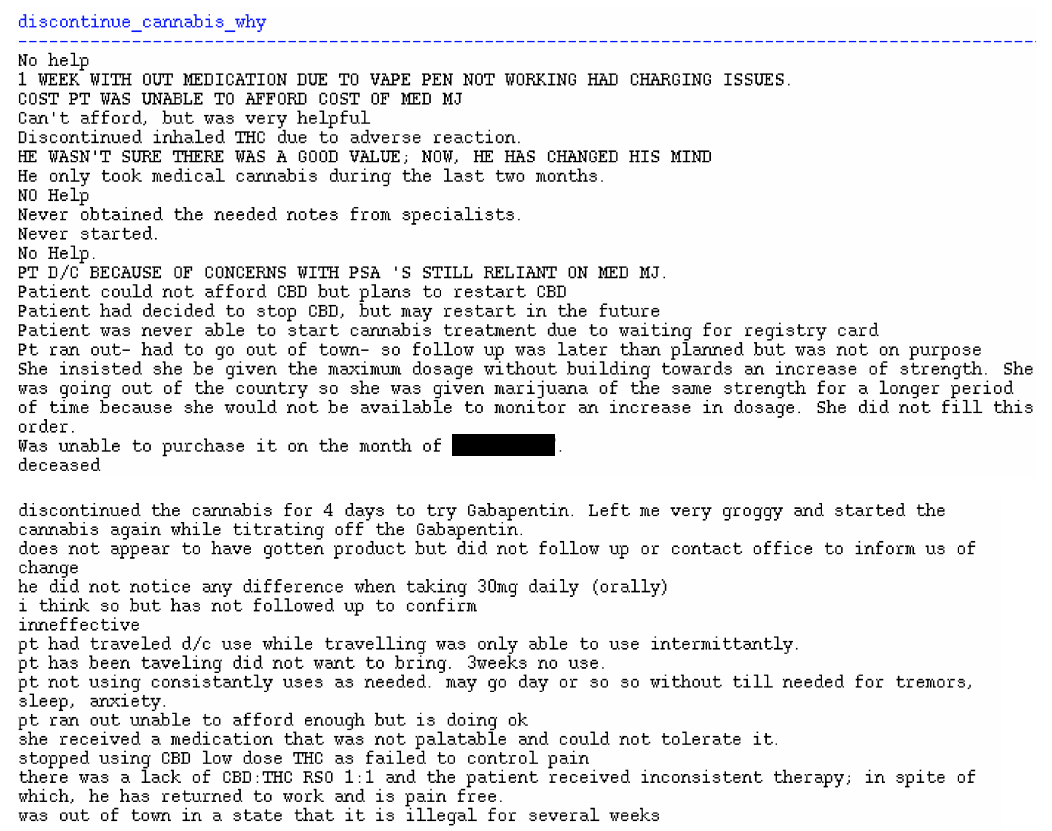
Figure A4. Reasons for Discontinuation of Cannabis During Follow-up Visits; N = 33 entries.